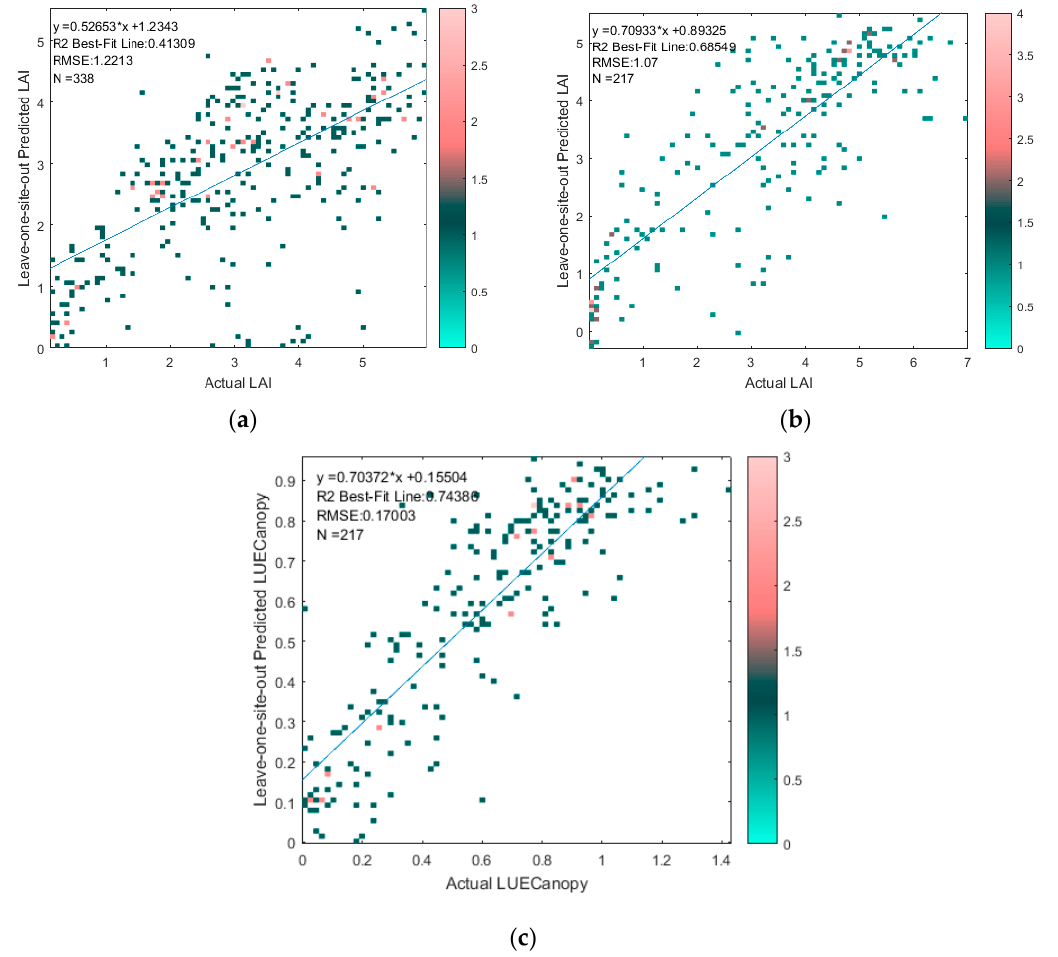
Figure 3. Comparison of retrieved versus actual ( a ) LAI from LAIGROUND dataset, ( b ) LAI from FLUX dataset, and ( c ) LUE Canopy from FLUX dataset from LANDSAT measurements via leave-one-site-out cross validation. The color bars represent the number of points at each marker on the scatter plot. Table 3. Leave-one-site-out LAIGROUND LANDSAT regression retrieval performance using Equation (4). a and b are the leave-one-site-out regression coe ffi cients defined in Equation (4). Best-Fit Lower Bound Upper Bound Coe ffi cients Confidence Interval Confidence